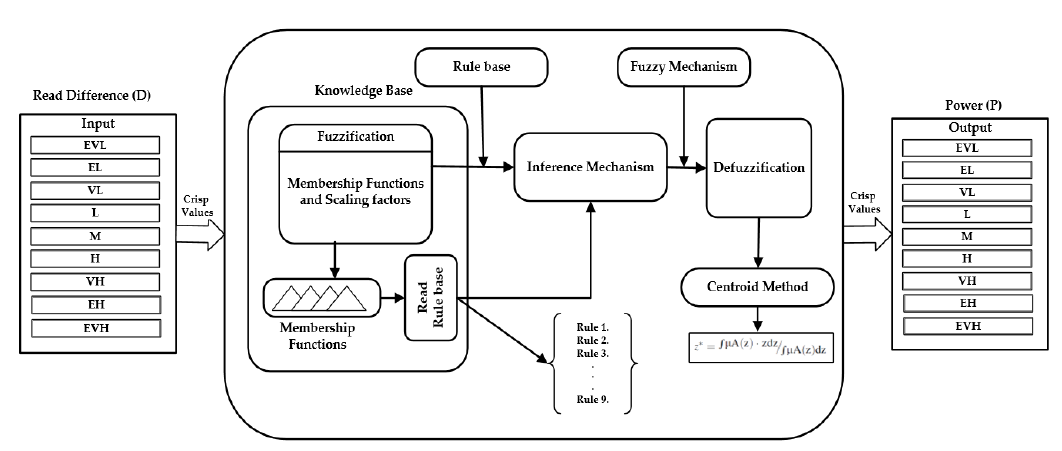
Figure 5. Structure diagram of Mamdani fuzzy logic used in this work.